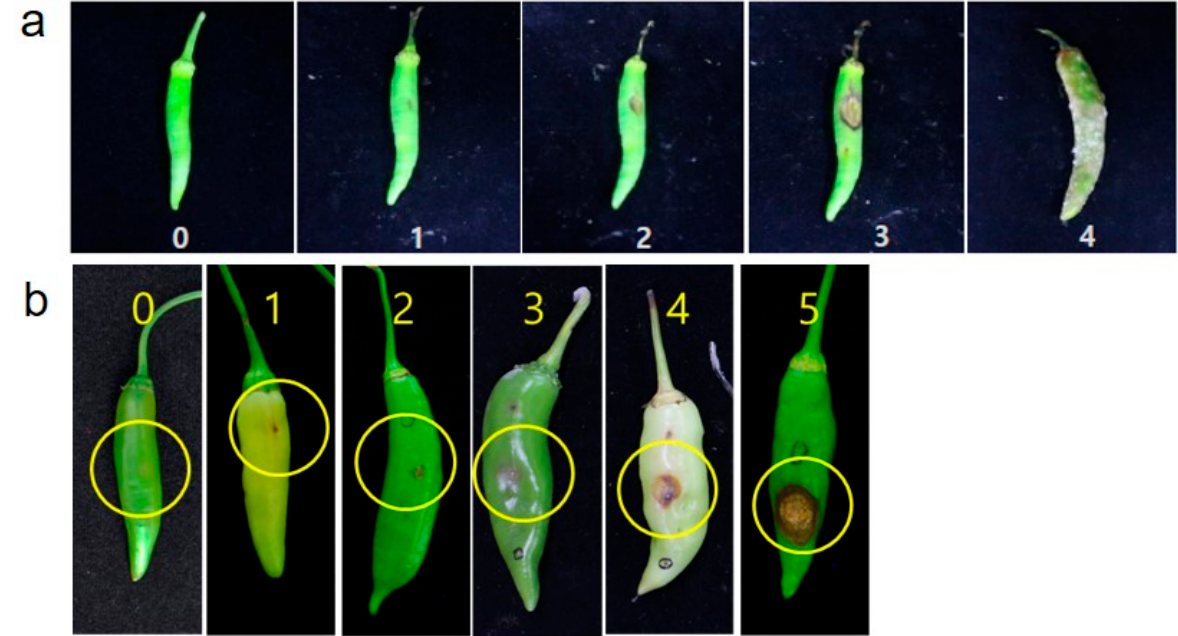
Figure 1. Disease severity of C. acutatum according to symptoms of each inoculation method. ( a ) Disease rating scale (0–4) of non-wounding inoculation (spray) and ( b ) Disease rating scale (0–5) of wound inoculation (microinjection).